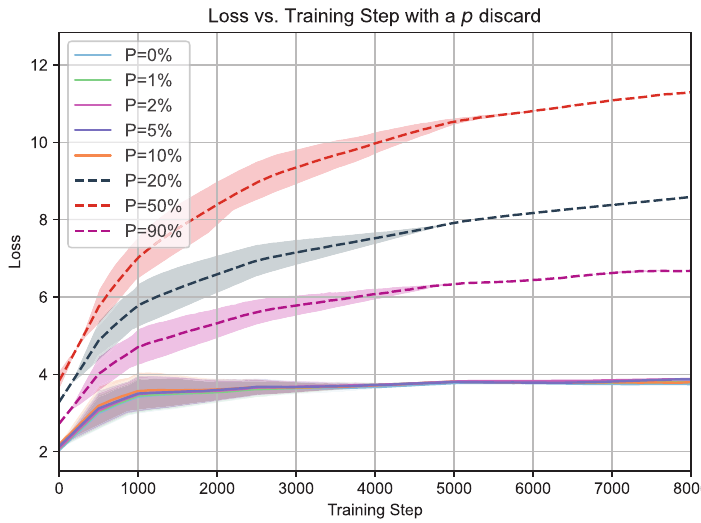
Figure 8. The loss value with different discard factor p .